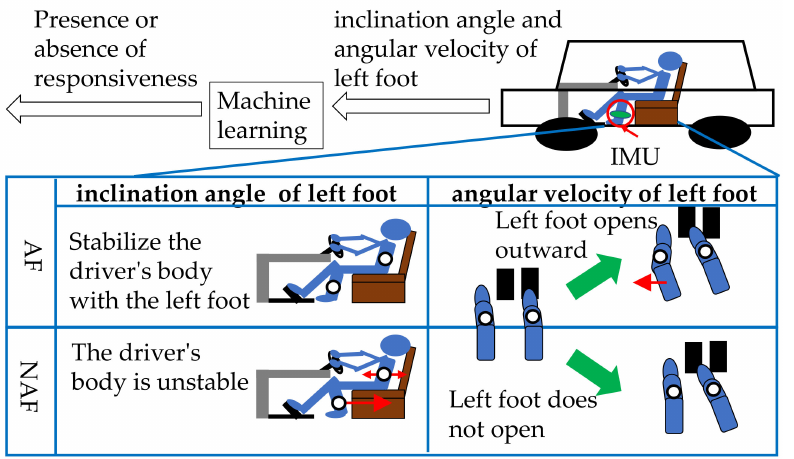
Figure 2. The coping skills prediction (CP) system in which machine learning predicts coping skills from the tilt angle and angular velocity of the left foot when an older driver is driving or starts preparation